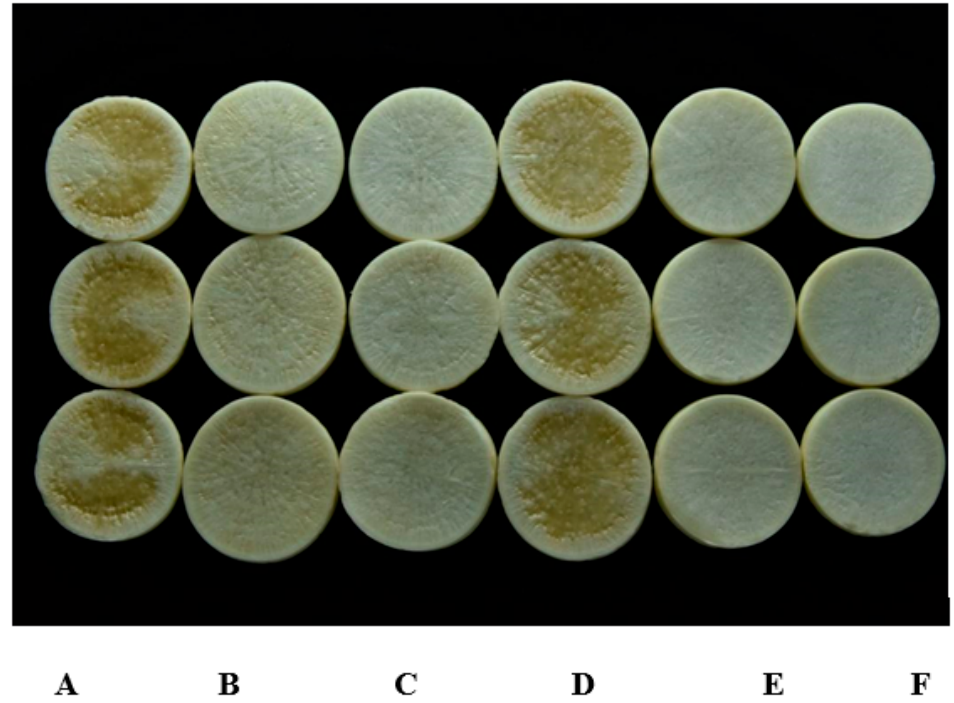
Figure 6. Biocontrol test of strain HN-2 against black rot disease on radish slices under laboratory conditions. ( A ) Xcc XC1 inoculated alone on radish. ( B ) Xcc XC1 + HN-2. ( C ) Xcc XC1 + agricultural streptomycin. ( D ) Xcc XC1 + E. coli DH5 α . ( E ) HN-2 inoculated alone on radish. ( F ) Distilled water (D/W) inoculated on radish as control.